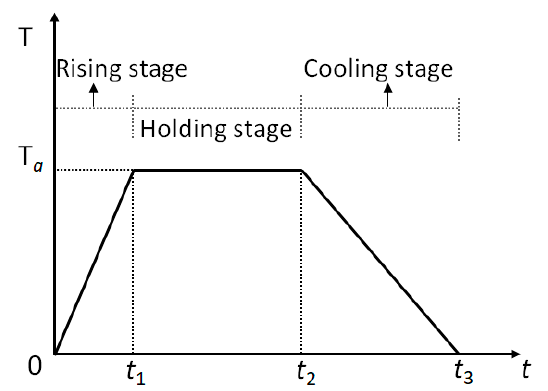
Figure 9. Layered spalling model.